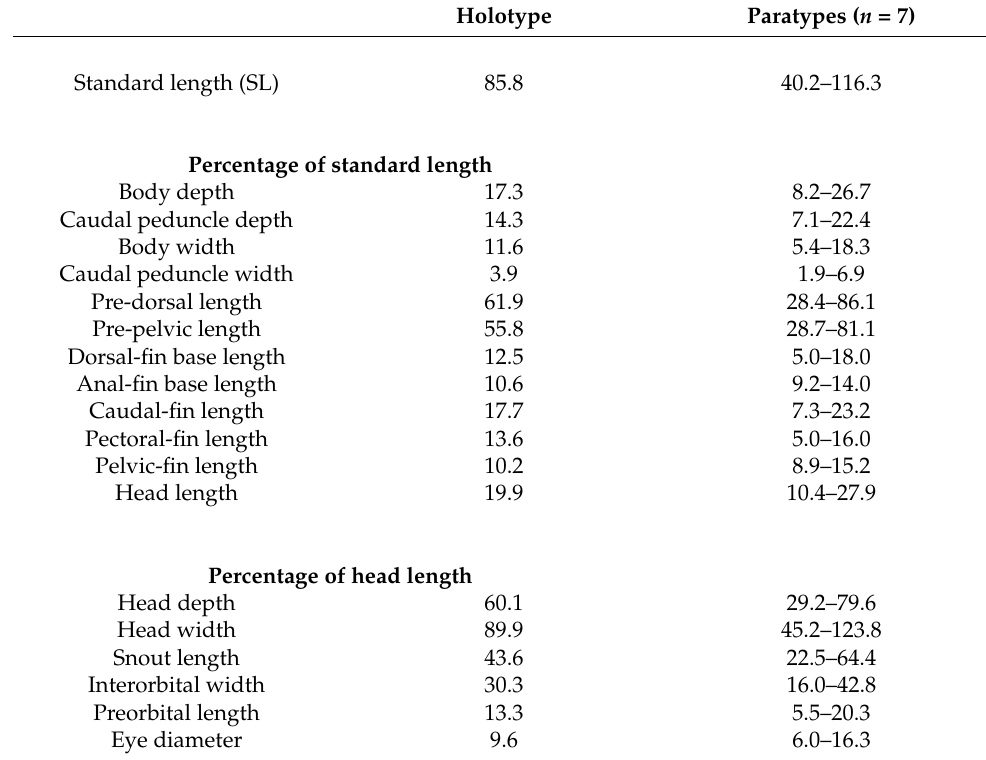
Table 3. Morphometric data of Trichomycterus saturatus Costa, Katz & Azevedo-Santos sp.